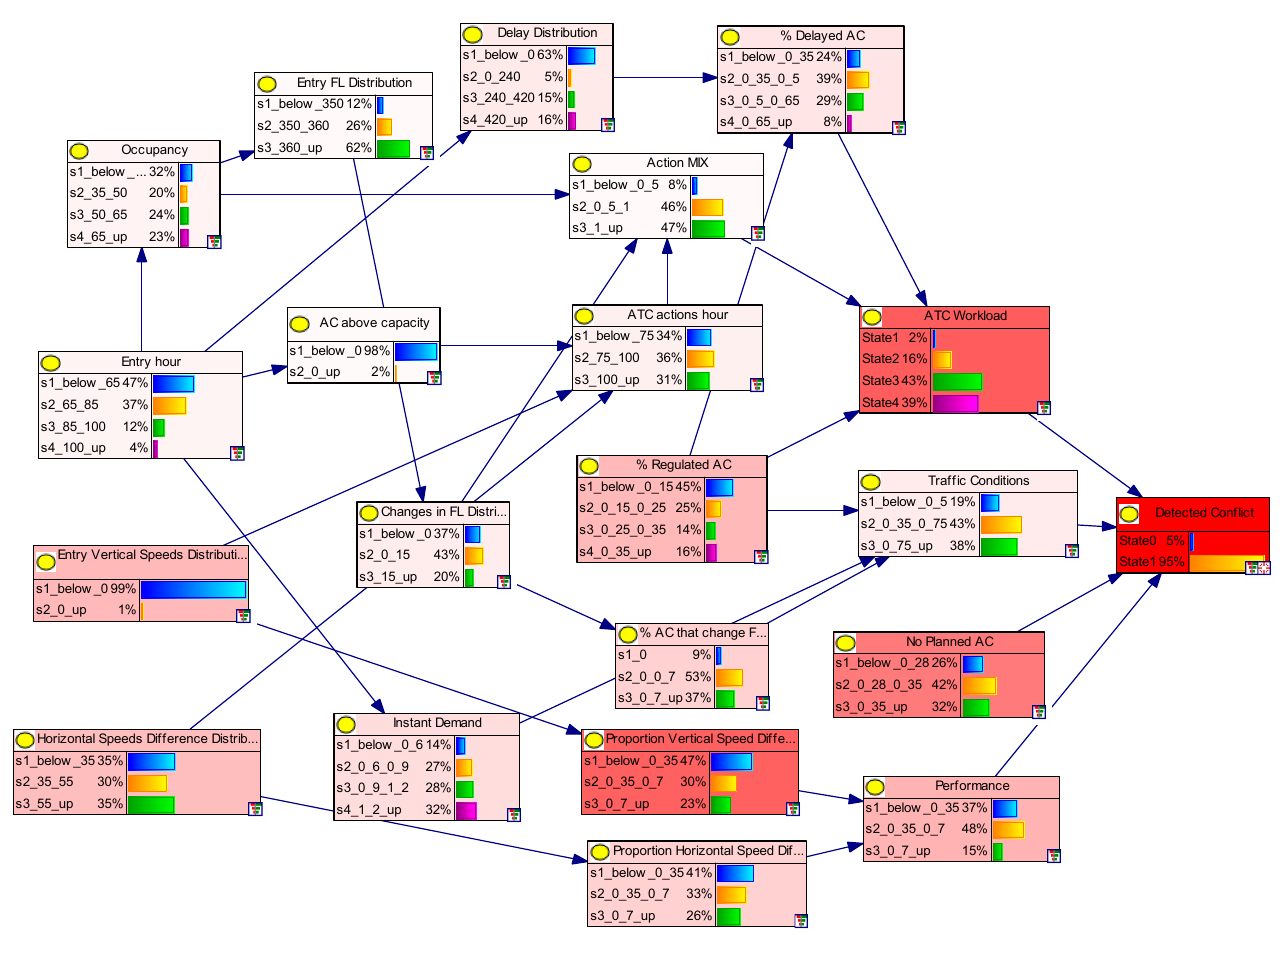
Figure 4. Sensitivity Analysis.